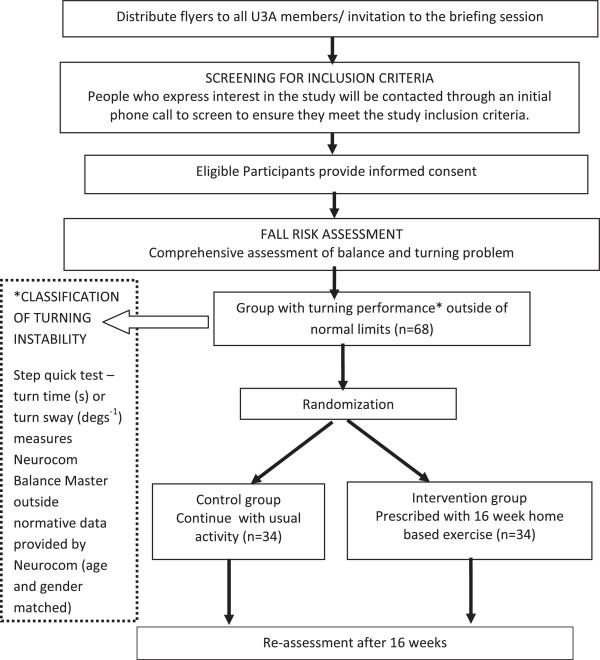
Flowchart of study.